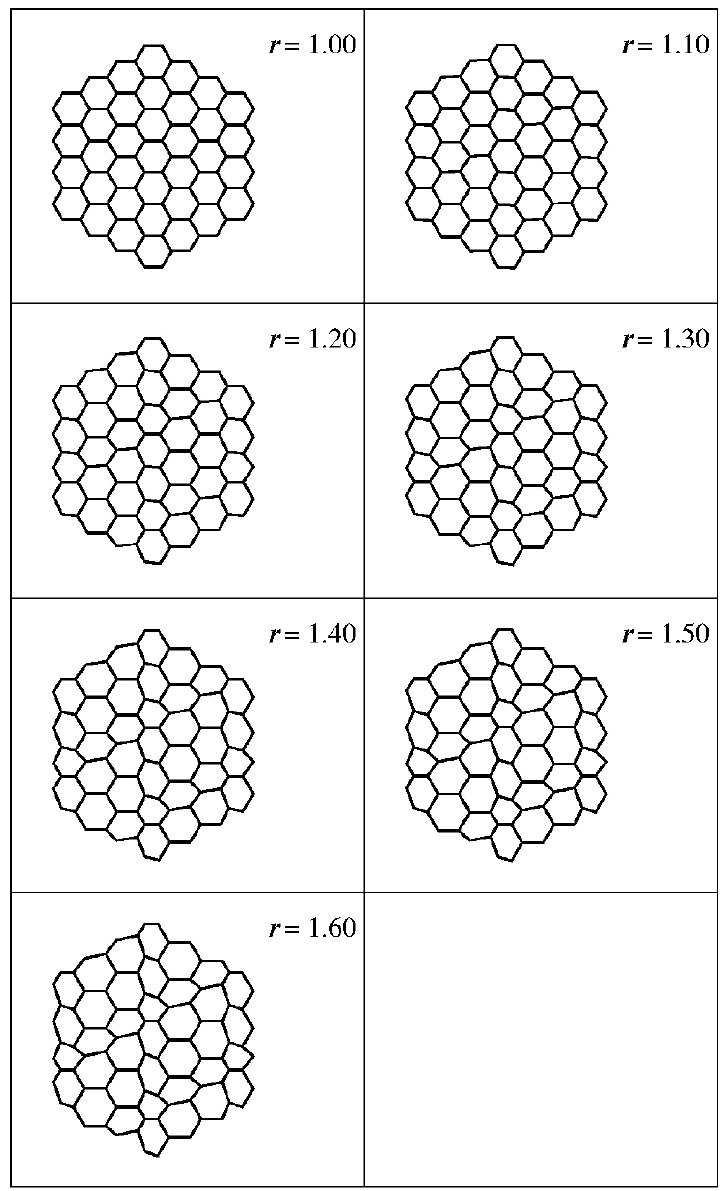
Figure 2. Progressive geometric distortion of the Kagome ASI, with indication of the distortion parameter r